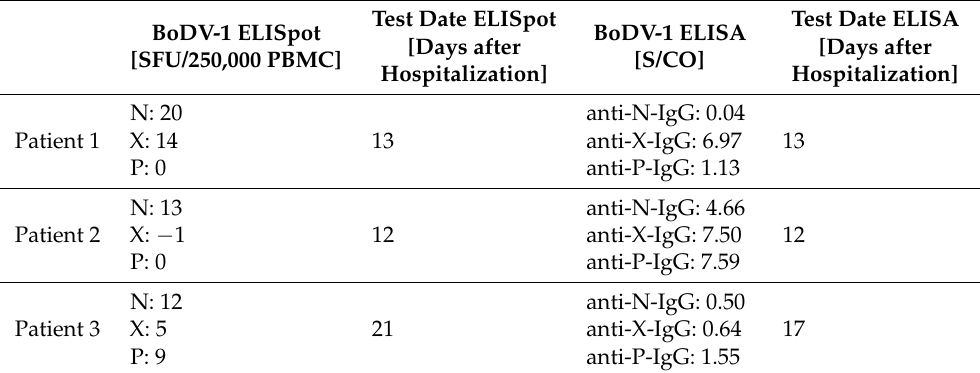
Table 2. Comparison of BoDV-1 ELISpot and BoDV-1 ELISA. BoDV-1